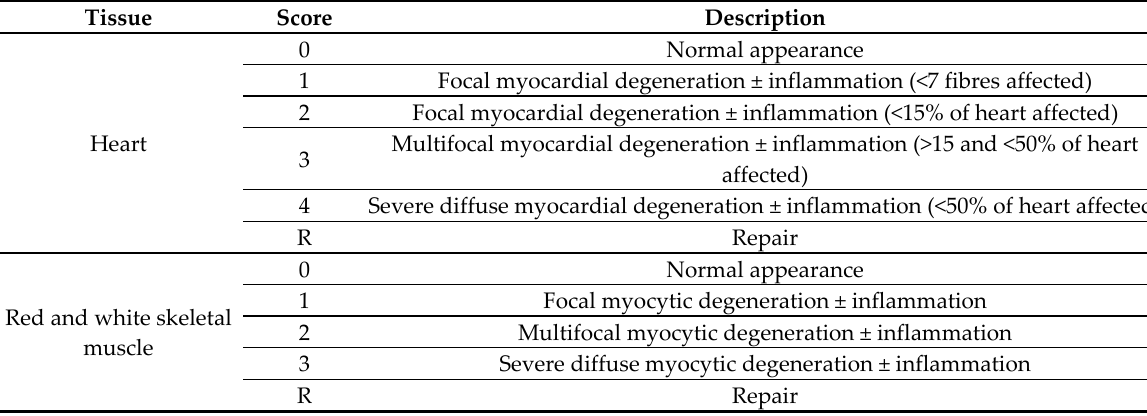
Table 1. Histopathology scoring ladder used in this study. From Graham et al., 2011. Tissue Score